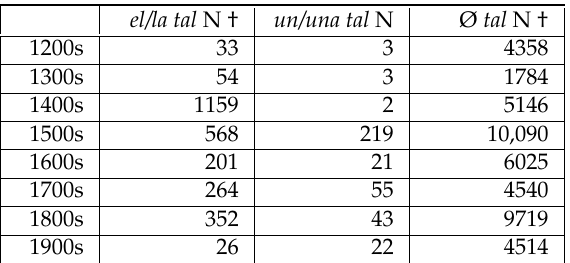
Table 14. tal in CdE (raw